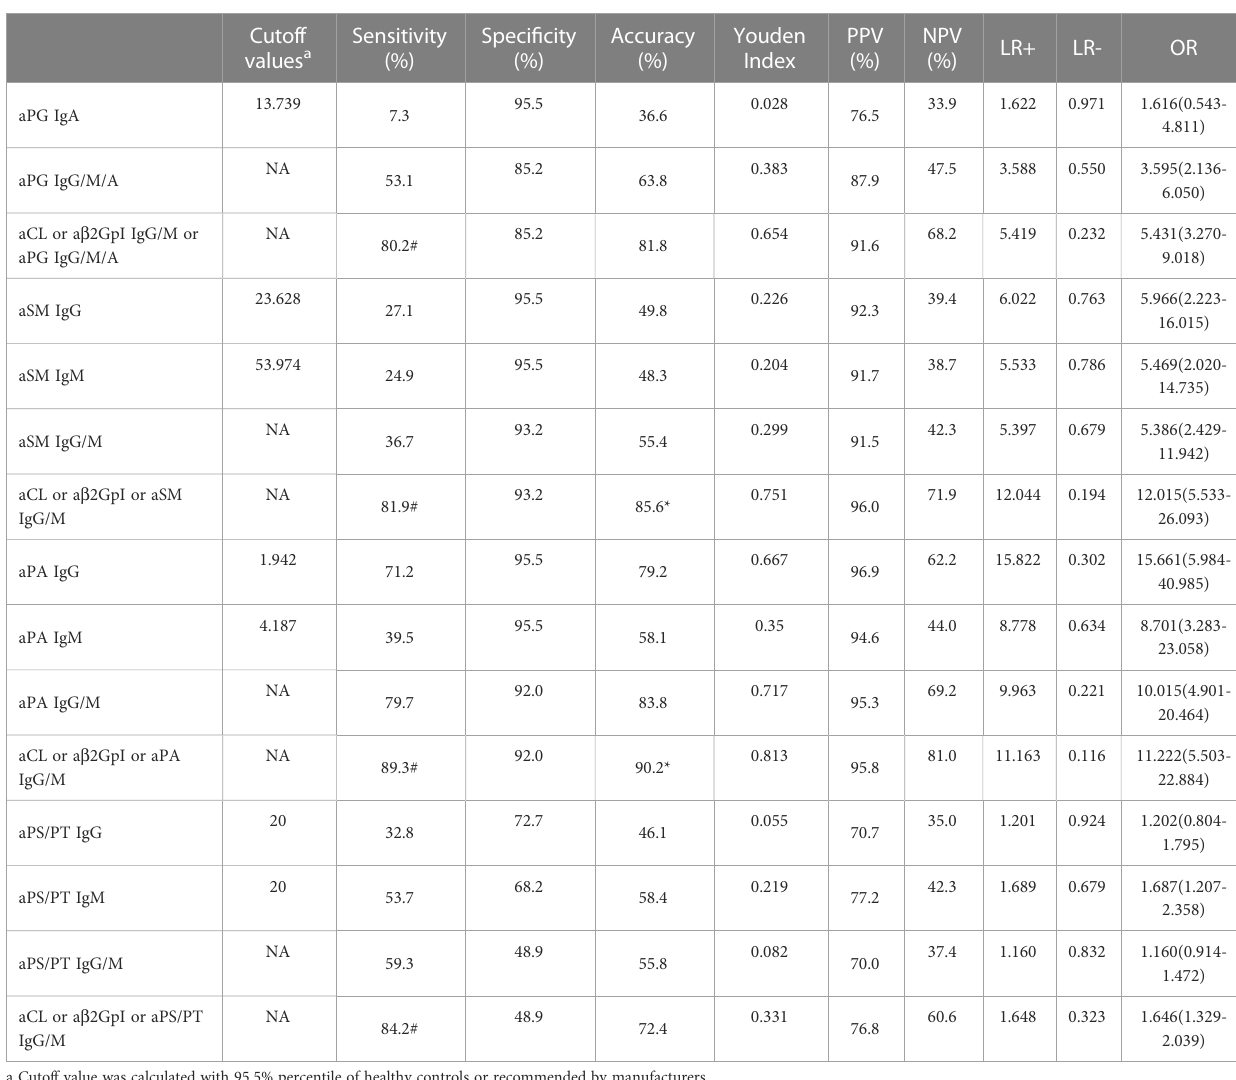
to other groups, and all four disease groups had signi fi cantly more aPLs positivity compared to healthy subjects. For 9 SNAPS patients, the number of positive non-criteria aPLs was listed in Supplemental Figure 1. Eight out of 9 SNAPS patients were positive for at least 1 aPLs, of which 1 patient had 11 positive non-criteria aPLs, 2 patients had 5 positive aPLs, and 5 patients had